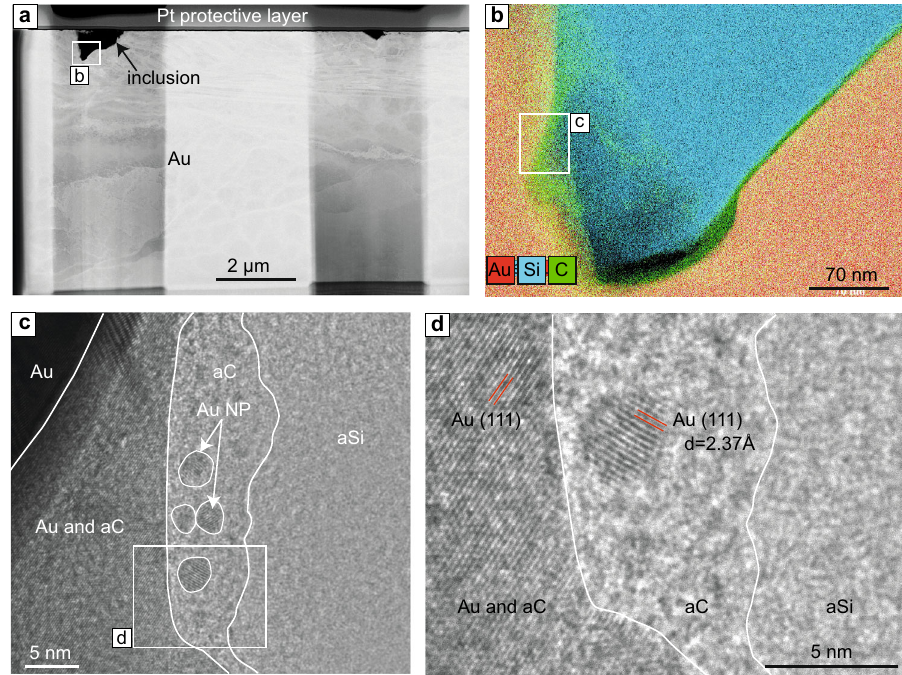
Fig. 3 Beta Hunt nanoparticles in amorphous carbon and silica. a High-Annular Dark Field Scanning Transmission Electron Microscopy (HAADF-STEM) image of the entire Beta Hunt foil showing a large inclusion on the left-hand side and a smaller inclusion on the right-hand side of the foil. b Energy- dispersive X-ray spectroscopy (EDS) elemental map of the part of the largest inclusion (indicated by a white rectangle in Fig. 3a) showing amorphous silica in the centre of the inclusion and a thin carbon layer at the interface with gold. c Transmission Electron Microscopy (TEM) image of the area within the white rectangle in Fig. 3b. The image shows amorphous silica (aSi) in the right-side of the image, amorphous carbon (aC) concentrated along the interface between the amorphous silica and the host gold, numerous rounded Au or Ag NPs (Au NP) are encapsulated in the amorphous carbon phase. d High Resolution TEM image of the area indicated by a white rectangle in Fig. 3c. showing 5 nm Au (or Ag) NP in amorphous carbon. A d-spacing of 2.37 Å was obtained for the metal NP using FFT analysis and was matched with Au, Ag, or Au-Ag alloy crystal